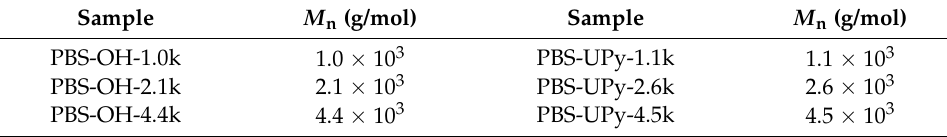
Table 1. The number-average molecular weights ( M n s) of PBS-OH and PBS-UPy samples. Sample M n (g/mol) Sample M n (g/mol)